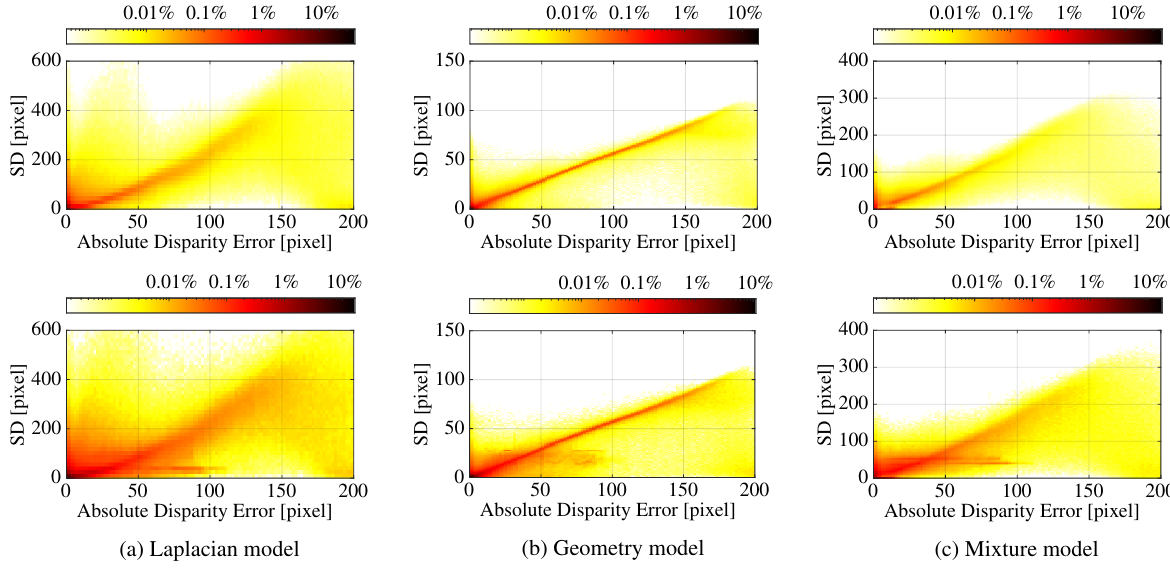
Figure 3. Absolute error uncertainty relation. The results are based on the first 100 images of the KITTI 2015 dataset using cost volumes computed with Census-based block matching. From top to bottom, the “good” and the “hard” regions are shown. The logarithmic colour scale encodes the percentage of pixels showing the respective error and estimated standard deviation